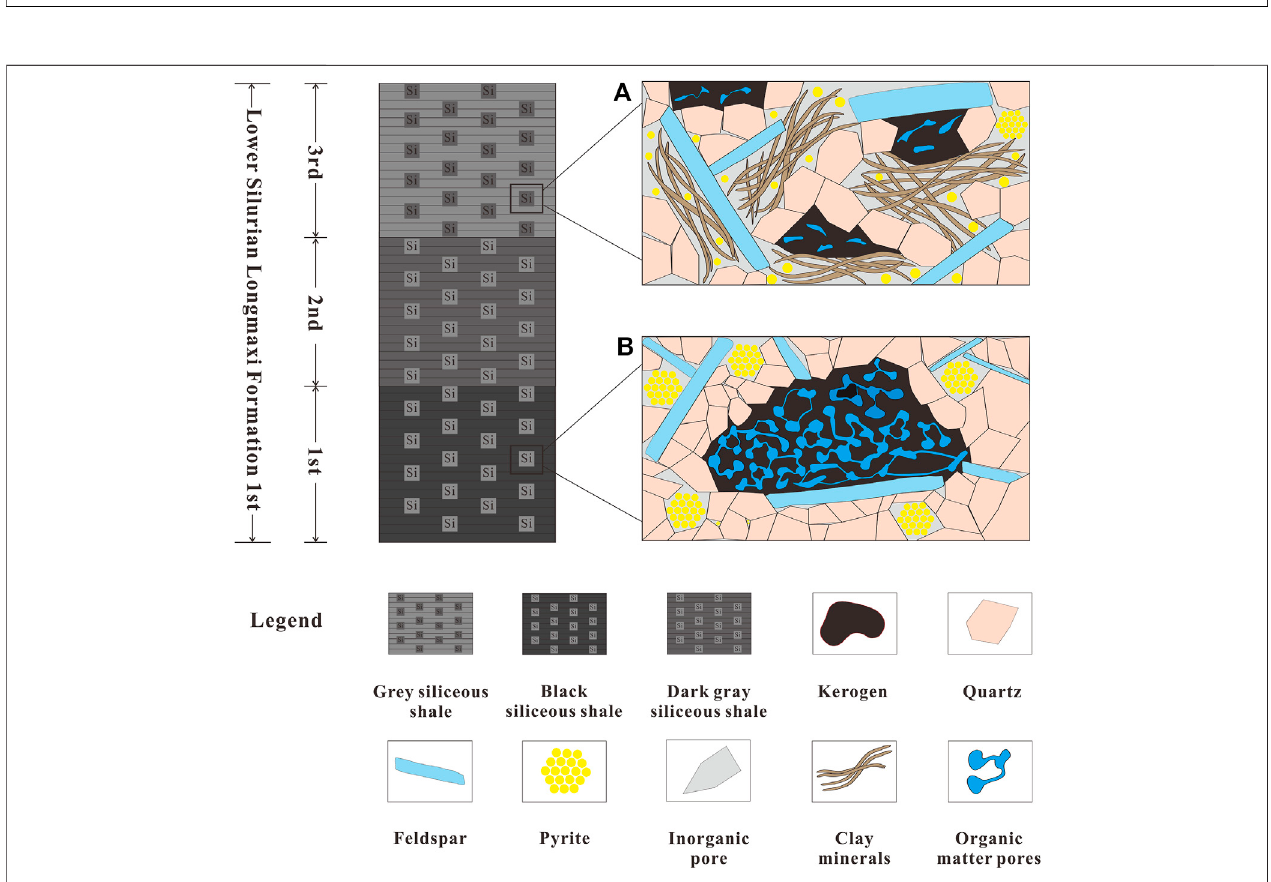
FIGURE 8 | Patterns of pore structure characteristics of marine shales with different TOC contents (A) : Organic shale; (B) Organic-rich shale.